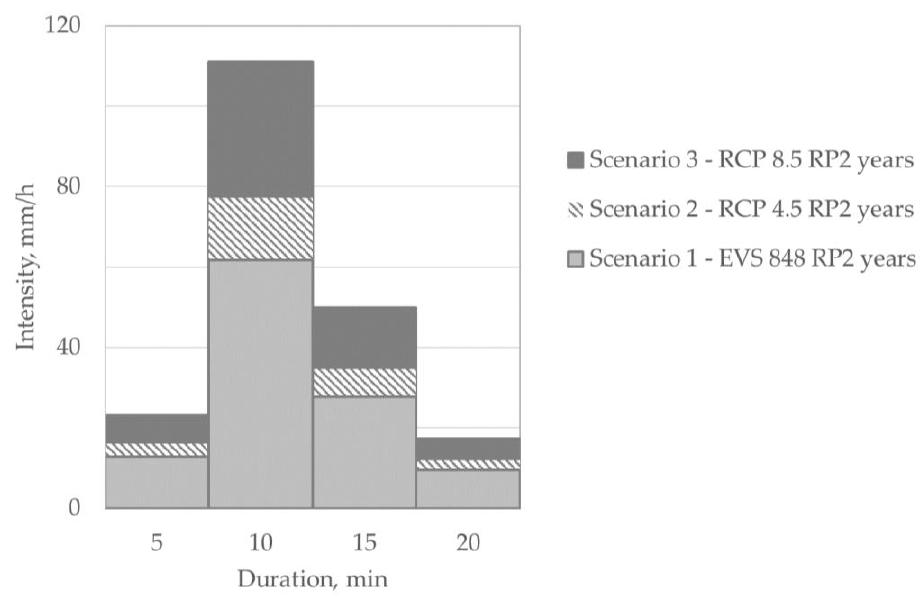
Figure 3. Rainfall intensity graphs for selected scenarios.